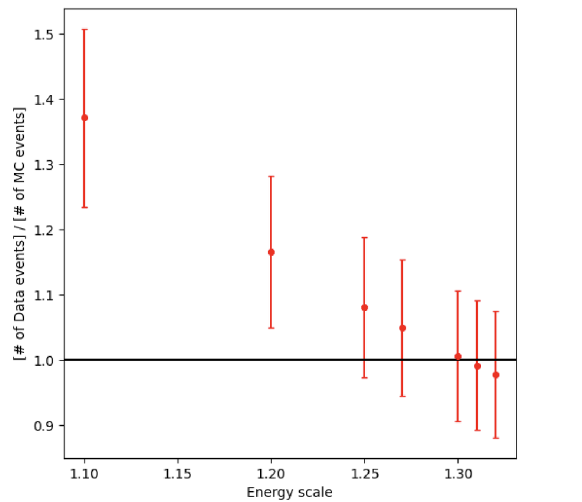
Figure 2: The ratio of the number of observed events to that of normalized MC simulation events for various en- ergy scaling factors. The error bars are statistical uncer- tainty of observed events. The energy scale which mini- mizes the di ff erence is